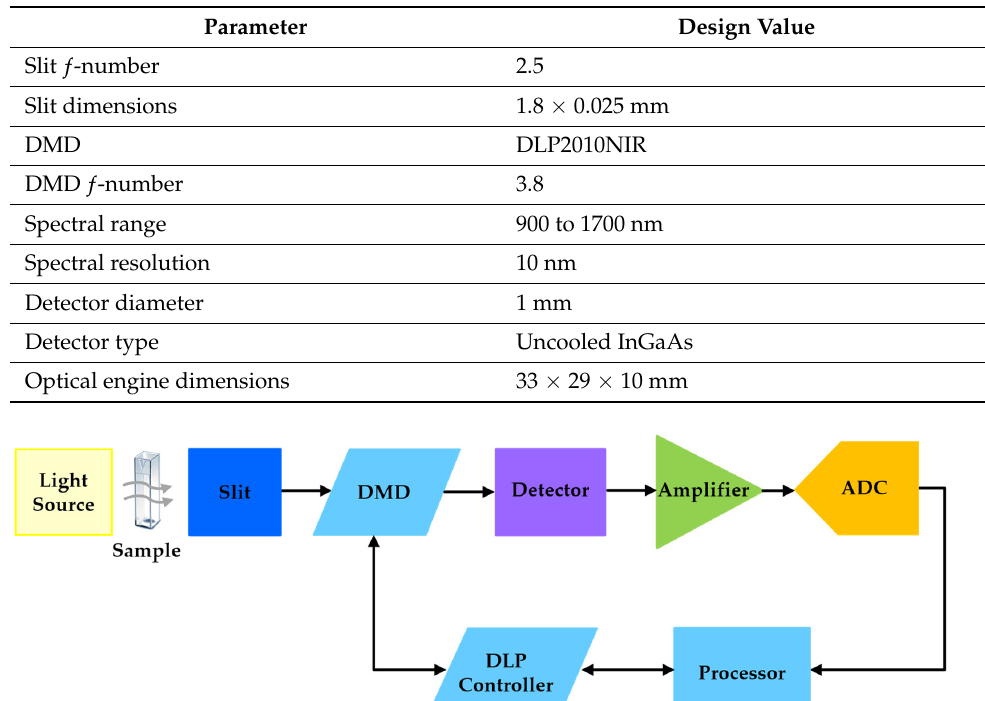
Figure 5. Interior view of the DLP NIRscan Nano-optical architecture. Table 2. NIRscan Nano EVM design specifications. Table 2. NIRscan Nano EVM design specifications.